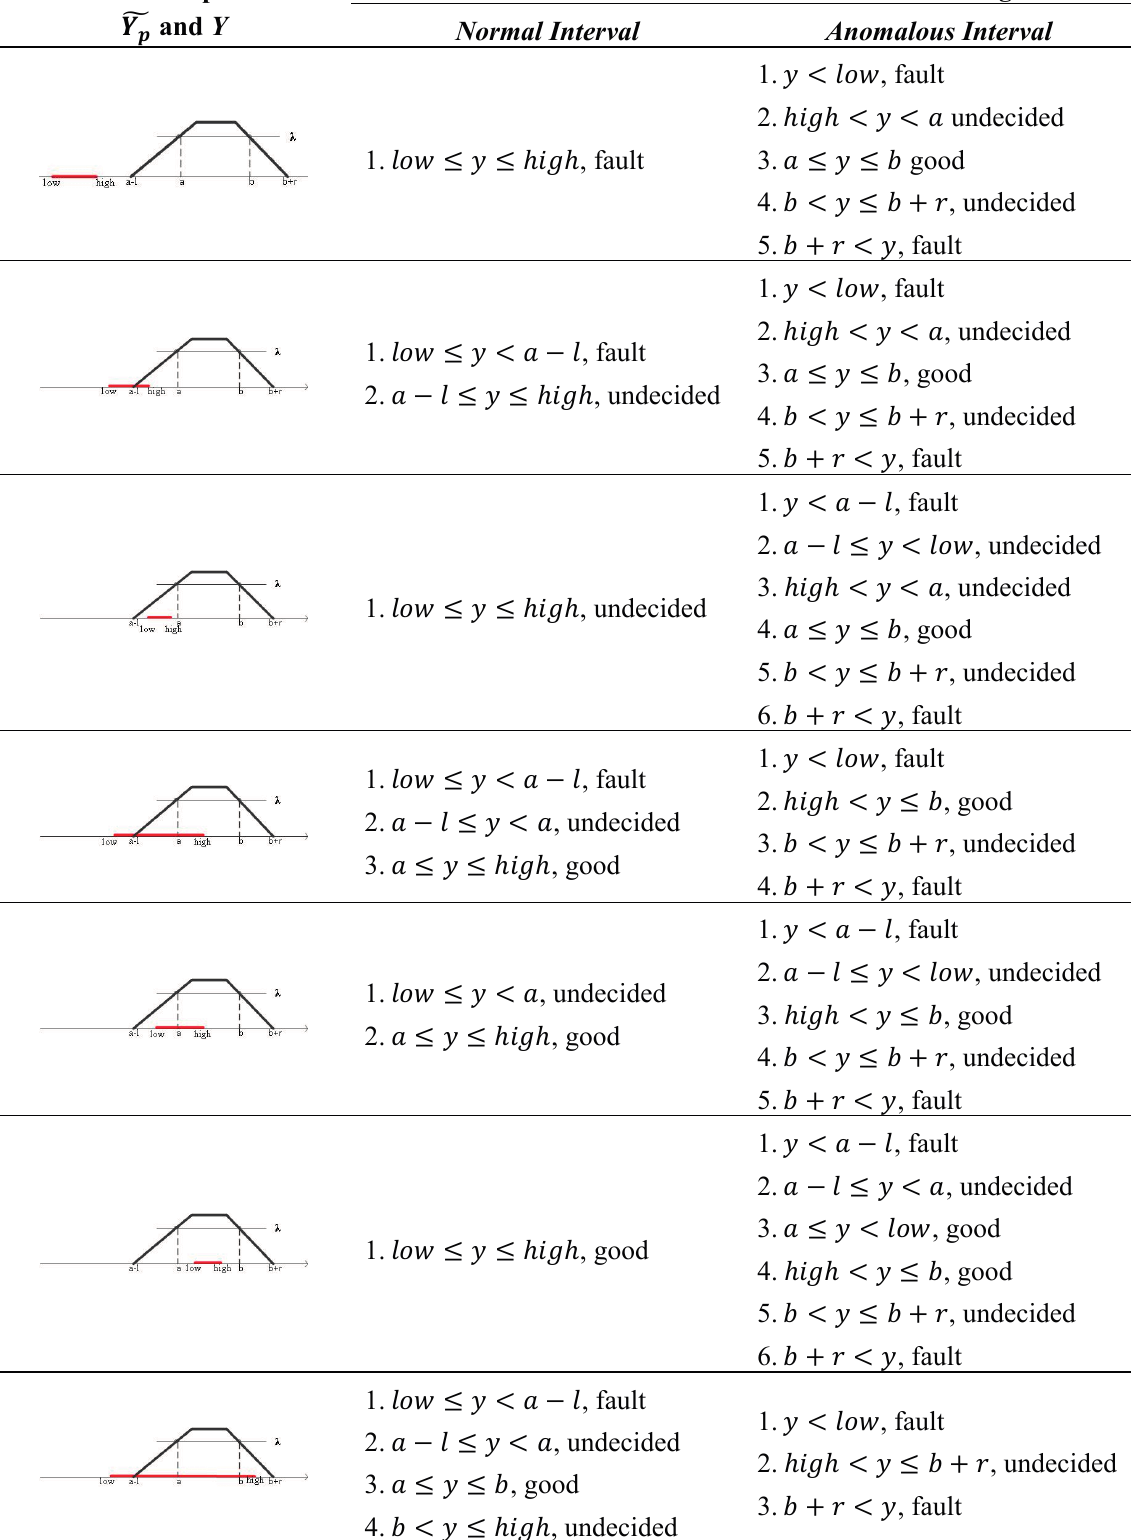
The Relationships